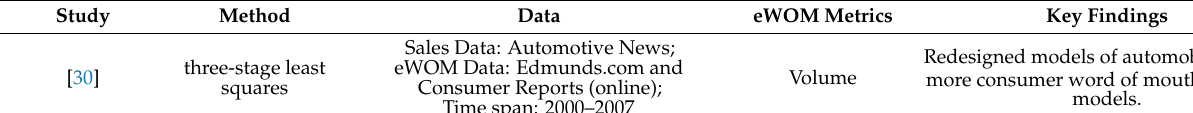
Table 1. Studies in context of automobile industry.